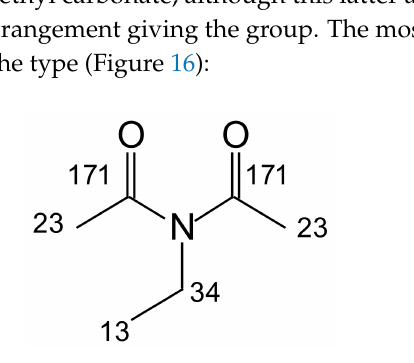
Figure 16. Example of rearranged group corresponding to the 164 ppm peak.